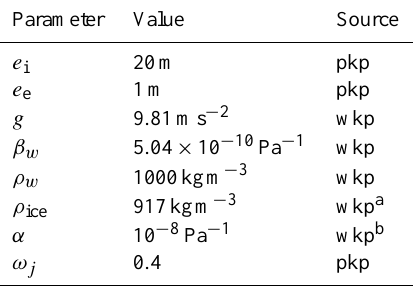
Table 2. Values of the parameters used in the hydrological model along with their sources. Well-known parameters are referenced as wkp and poorly known parameters are labelled